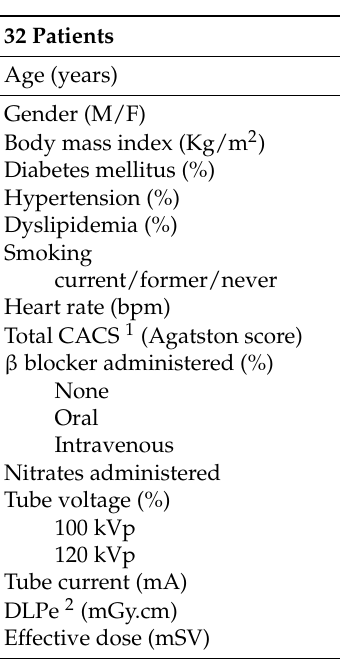
Table 1. Patient and scan